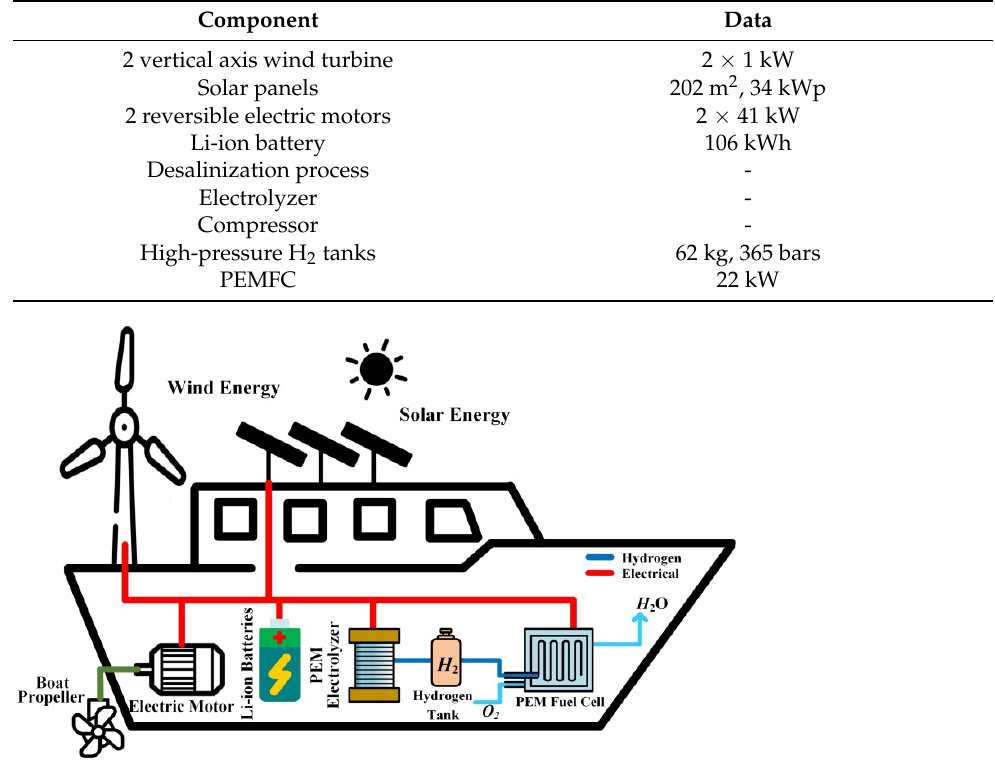
Figure 9. Power grid of the Energy Observer.